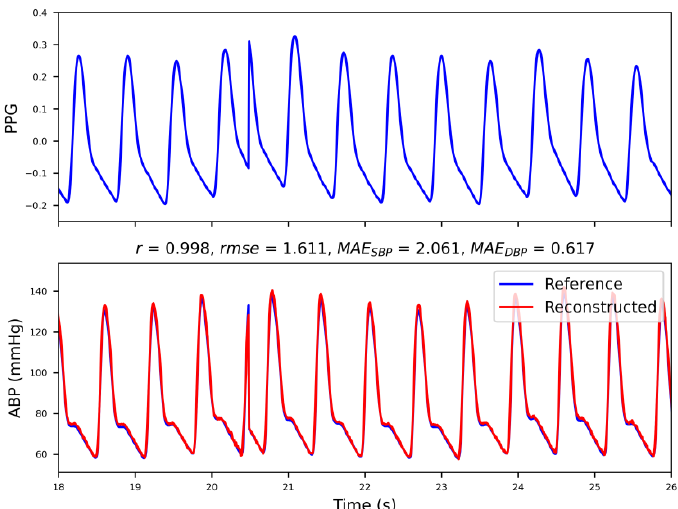
Figure 5. Demonstration of the reconstruction of the ABP waveform, where ‘ r ’ and ‘ rmse ’ stand for the correlation coefficient and the relative mean squared error, respectively, and ‘ MAE SBP ’ and ‘ MAE DBP ’ represent the mean absolute error of systolic and diastolic blood pressure, respectively. Note that PPG = Photoplethysmogram, ABP = Arterial blood pressure, SBP = Systolic blood pressure, and DBP = Diastolic blood pressure.